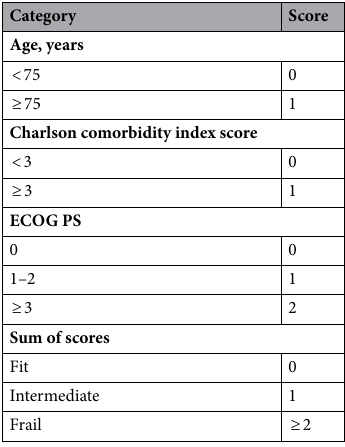
Table 2. Newly developed frailty scale scoring system. ECOG PS , Eastern Cooperative Oncology Group performance status.